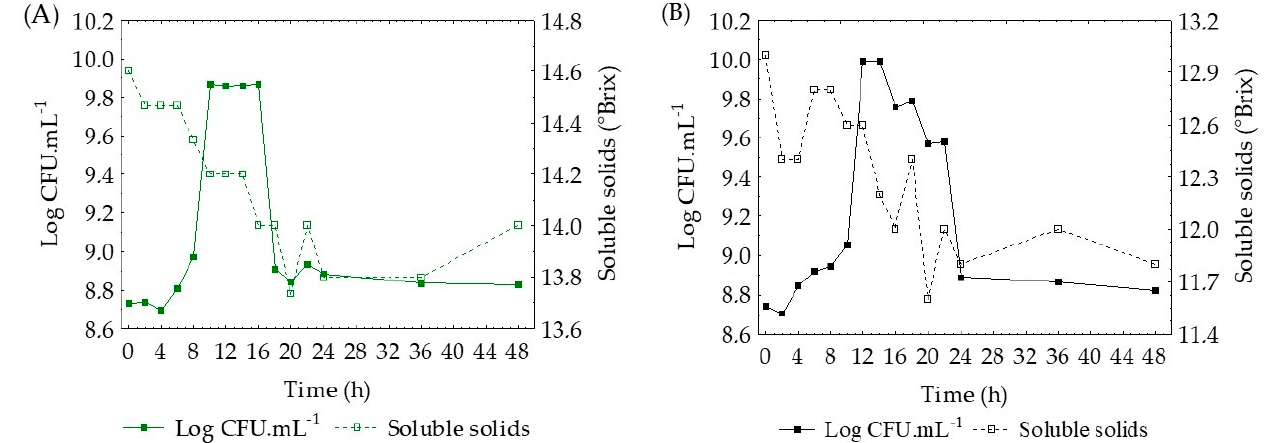
Figure 6. Monitoring of soluble solids with respect to cell concentration in the best fermentation conditions of passion fruit juice ( A ) and passion fruit with green tea ( B ).